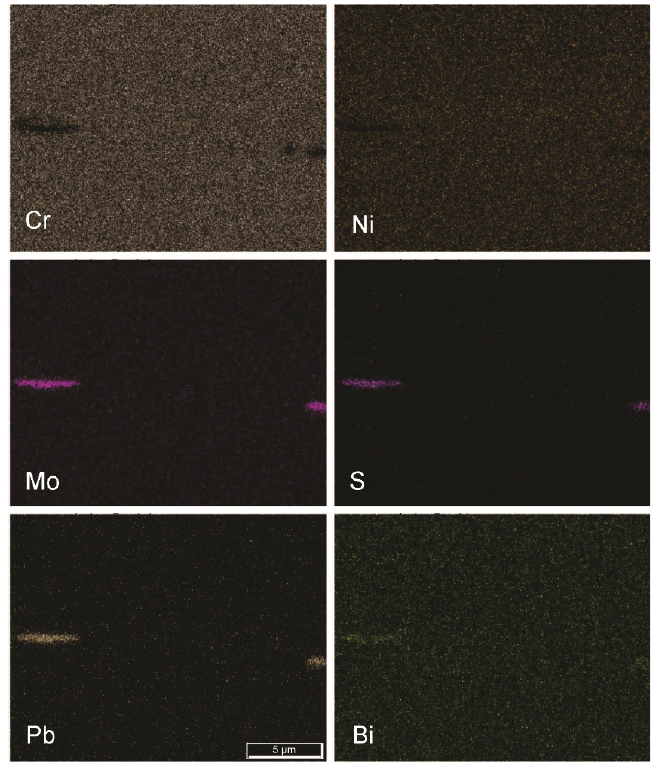
Figure 11. Segregation of Mo, S, Pb, and Bi in the hot-rolled plate of steel B (FE-SEM-EDS mapping; mag. 5000×).